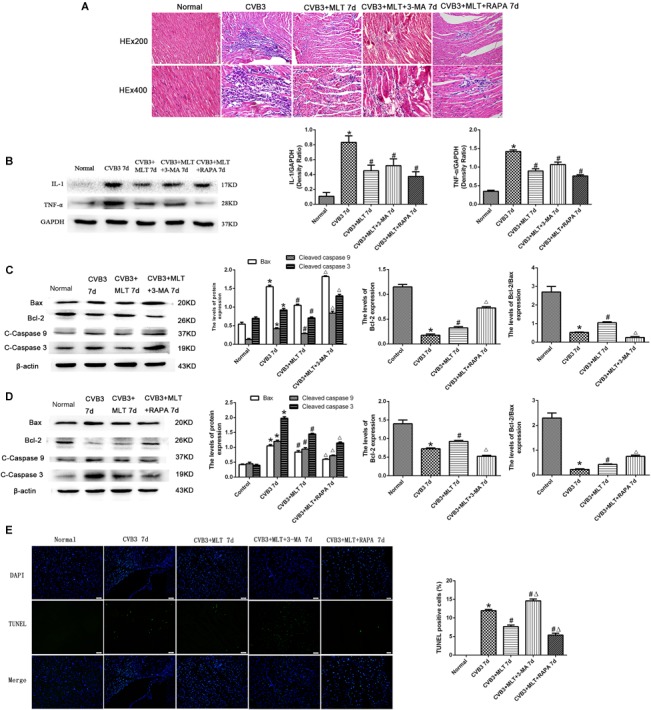
The effects of melatonin on inflammation and apoptosis on day 7. (A) Representative myocardial pathological changes on day 7 (n = 5 in each group, three sections per heart were examined). (B–D) Expression of proinflammatory cytokines, apoptosis-related protein Bax, Bcl-2, cleaved caspase-3, and cleaved caspase 9 in the myocardium on day 7 (n = 5 in each group). (E) Double staining for DAPI (blue) and TUNEL (green) of sections from myocardium on day 7, scale bar = 50 μm (n = 5 in each group). ∗P < 0.05 versus the normal group, #P < 0.05 versus the CVB3 group, ∆P < 0.05 versus the CVB3 + MLT group.